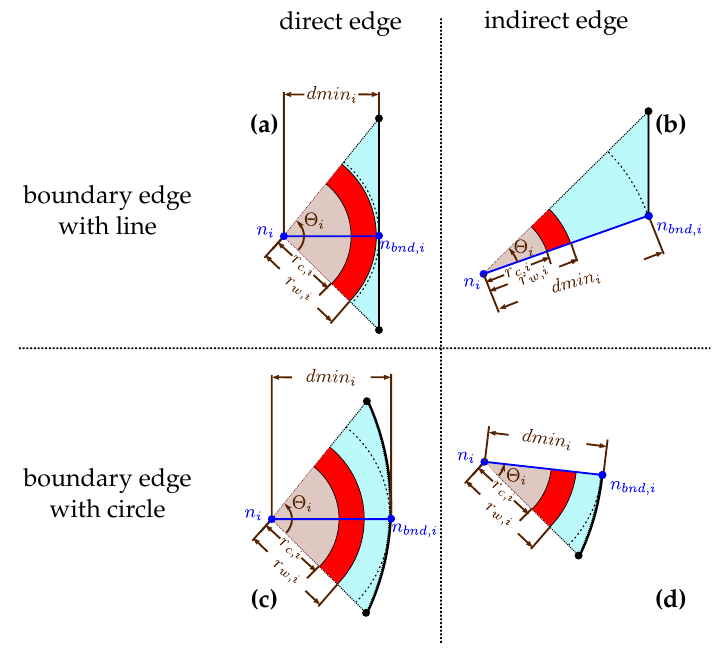
Figure 7. Cutting a boundary cell with the 4 possible cases: direct edge with a line border ( a ) or an arc border ( c ) and indirect edge with a line border ( b ) or an arc border ( d